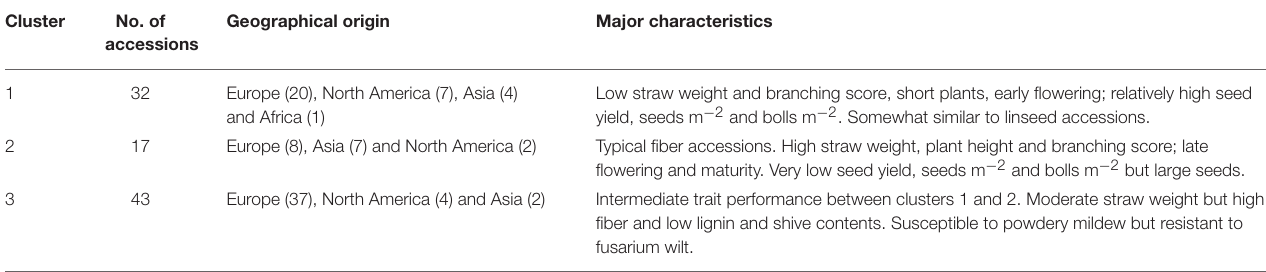
TABLE 2 | Summary of cluster analysis for 92 fiber accessions with 27 traits. Cluster No. of Geographical origin accessions